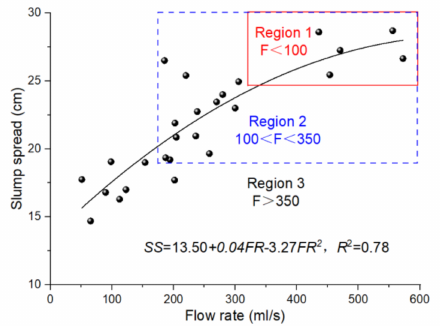
Figure 4. Relationship between slump spread and flow rate.